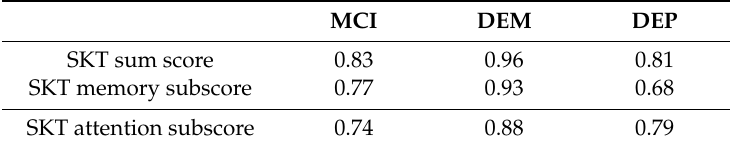
Table 3. Results of receiver operating curves (ROC): area under curve